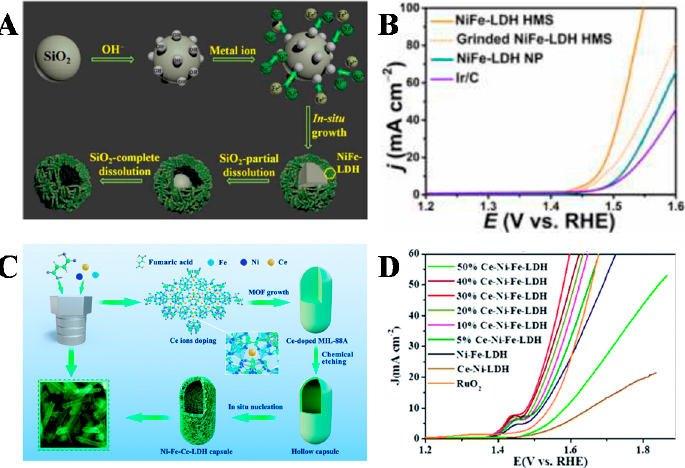
Figure 11. ( A ) Scheme of the Synthesis of NiFe-LDH HMS; ( B ) LSV curves of the catalysts at 1600 rpm in 1 M KOH [173]. Copyright © 2016 American Chemical Society. ( C ) Schematic illustration of the fabrication of hollow Ni-Fe-Ce-LDH microcapsules mediated by cerium doping in MIL-88A; ( D ) polarization curves of Ni-Fe-Ce-LDH with different Ce/Fe ratios at 1600 rpm in 1 M KOH solution [175]. Copyright © The Royal Society of Chemistry 2020.